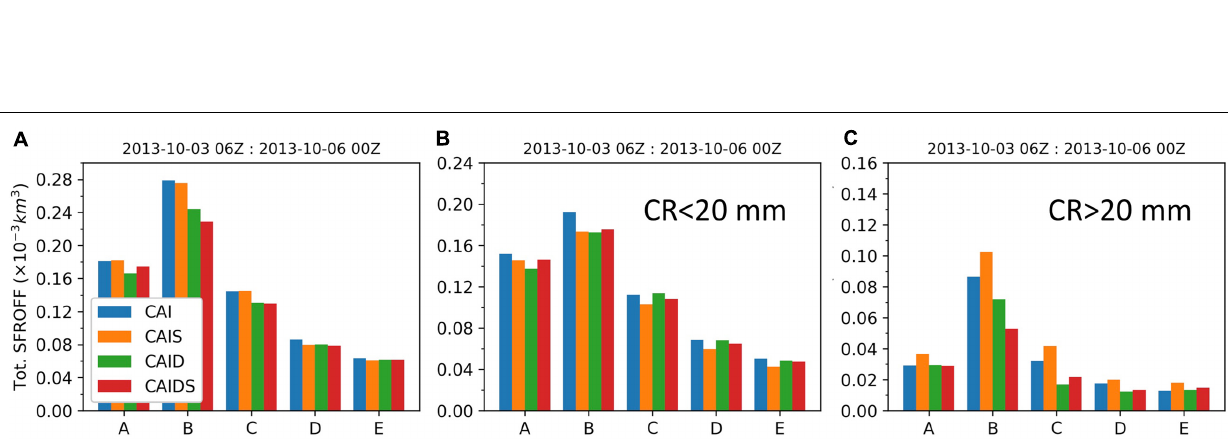
FIGURE 10 | Map of top 40 cm (top two layers) initial soil moisture conditions (D02, 6 km) for the CAI and CAIS WRF simulations (left panel). Maps (D03, 1.2 km) of differences in accumulative rainfall (mid panel) at the end of the simulation and in surface runoff (right panel) between CAI and CAIS; CAID and CAIDS. Blue (red) tones indicate higher (lower) values for CAIS (CAID and CAIDS).